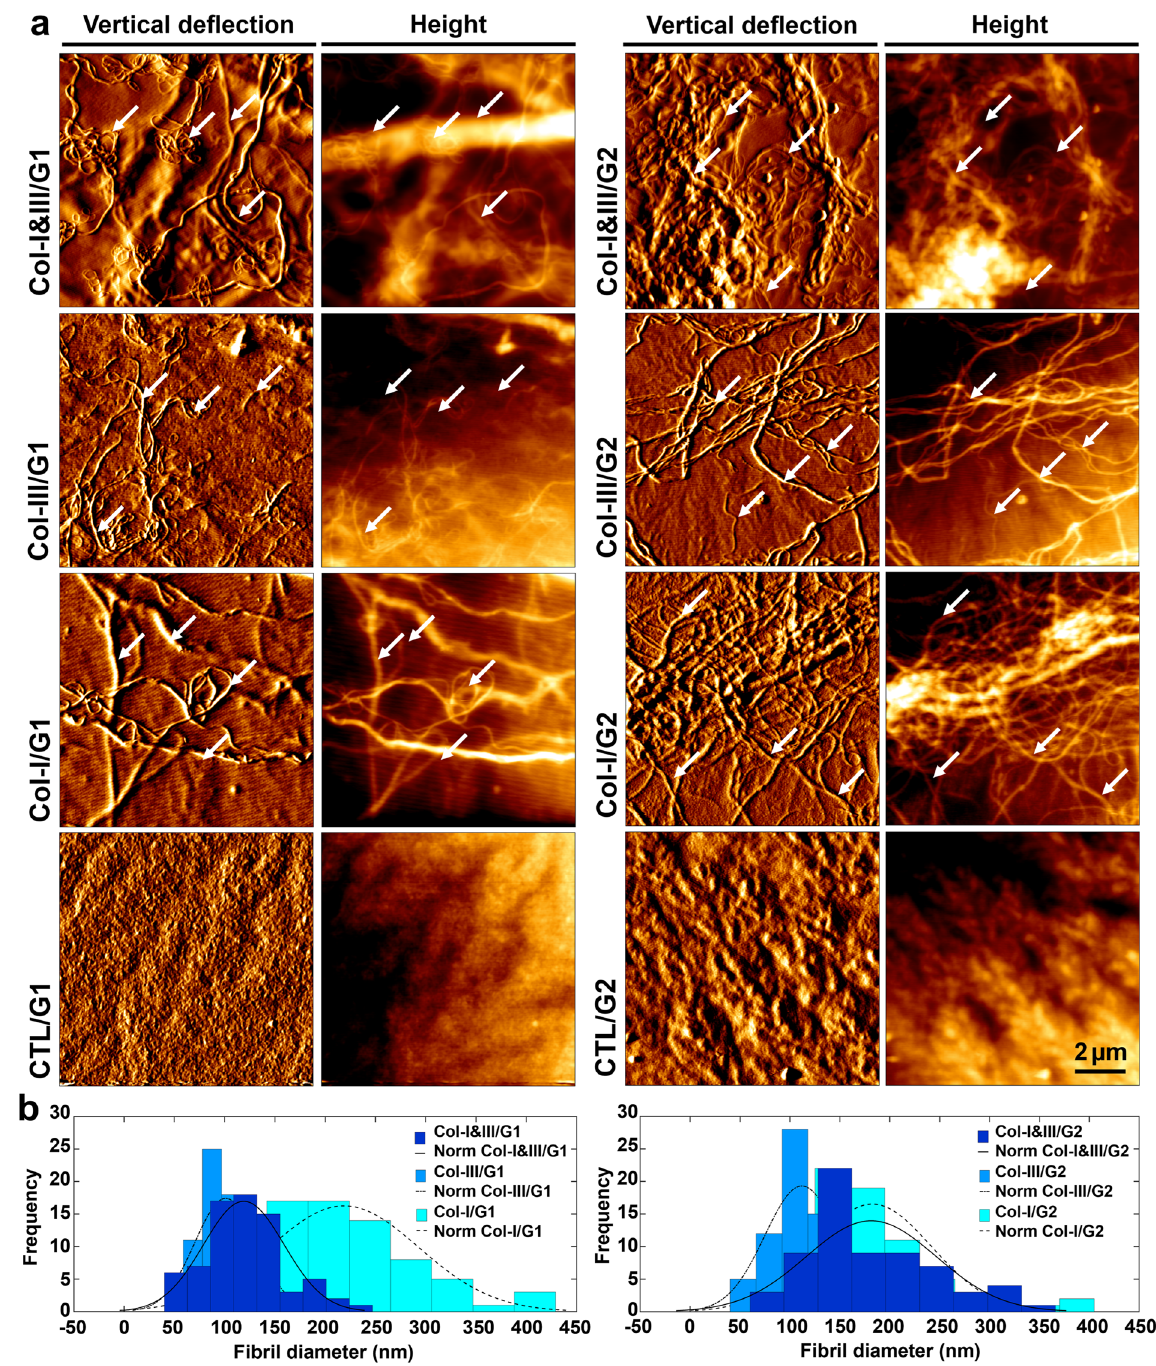
Figure 2. Atomic force microscopy (AFM) results. ( a ) Representative AFM images, vertical deflection and height images, of the proposed collagen (Col)/glycol-chitosan (GCS) hydrogels, Col-I&III/GCS and Col-III/ GCS, positive controls (Col-I/GCS) and negative controls (CTL/GCS). Tropocollagen molecules self-assembled into fibrils during the fabrication process, and thus semi-IPN networks of fibrillar collagen structure within a GCS matrix were formed. Representative fibrils are identified using white arrows. No fibrillar structure was observed for the negative controls; ( b ) Histograms of the obtained fibril diameters. The mode was smaller for Col-III/GCS, compared with that of associated Col-I&III/GCS, which was itself smaller than that of associated Col-I/GCS (Col-III: collagen type III, Col-I: collagen type I, Col-I&III: the simultaneous presence of Col-I and Col-III, and CTL: negative controls. G1 and G2 represent final GCS concentrations of 2% and 1%,